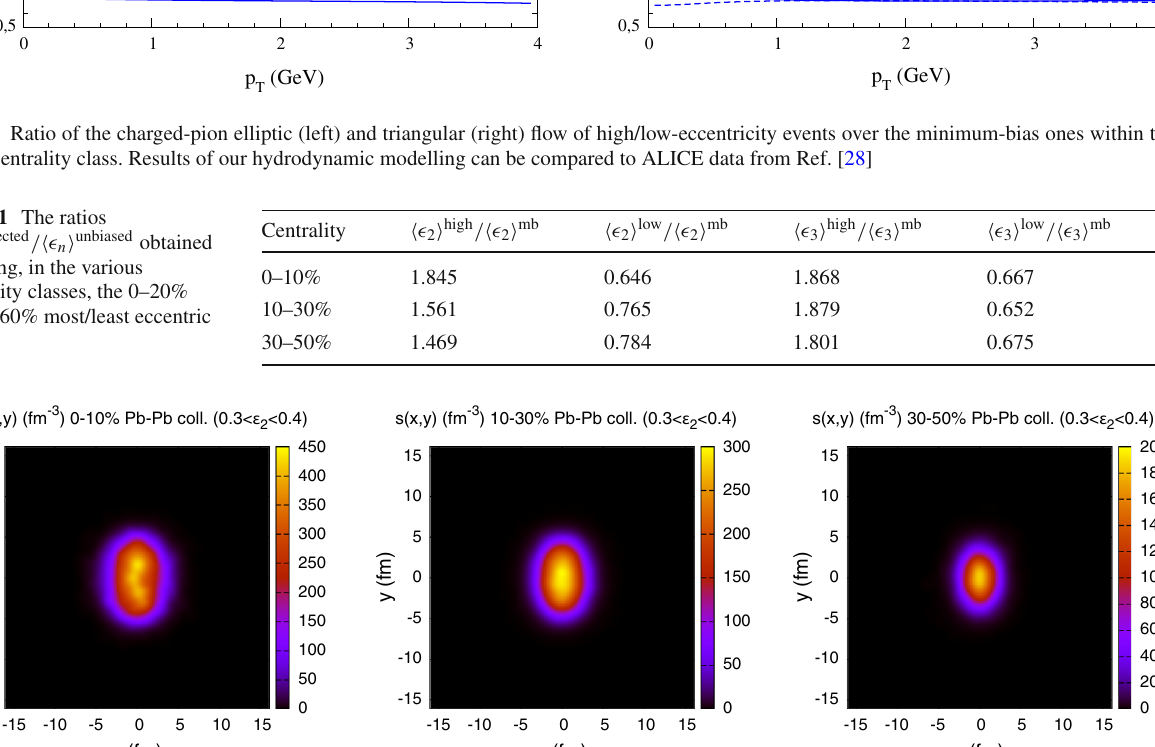
s NN = 5 . 02 TeV of fixed elliptic eccentricity 0 . 3 ≤ (cid:7) 2 ≤ 0 . 4 and different centrality